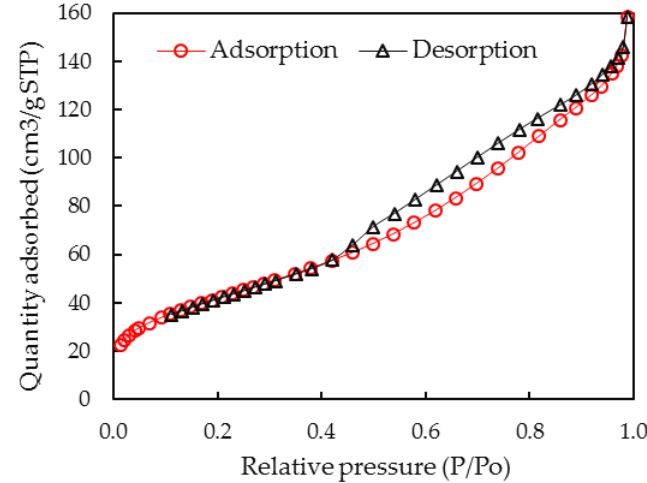
Figure 5. Adsorption isotherm of N 2 onto synthesized nano-aluminum hydroxide.